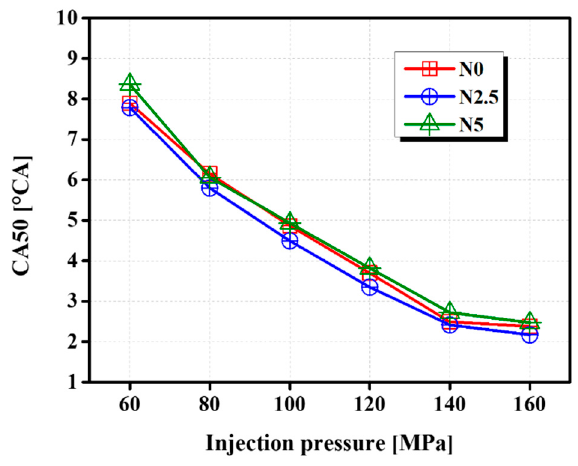
Figure 5. Variation in CA50 with injection pressure for n -octanol/diesel blends.